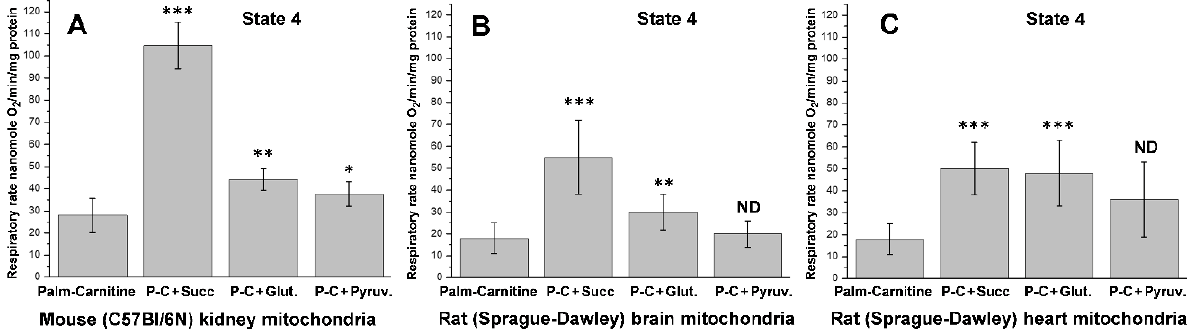
Figure 5. Effects of succinate, glutamate, and pyruvate on the resting oxidation of palmitoyl-carnitine (P-C) by the isolated kidney, brain, and heart mitochondria. Graphs show the oxygen consumption rates without ADP (State 4). ( A ) Mouse kidney mitochondria; ( B ) Rat brain mitochondria; ( C ) Rat heart mitochondria. The data are mean ± standard error. *** p < 0.001 Palm-Carnitine (P-C) vs. P-C + Succinate ( n = 5); ** p < 0.01 P-C vs. P-C + Glutamate; * p < 0.05 and No-Difference Palm- Carnitine vs. P-C + Pyruvate. Redrawn from ref [75].